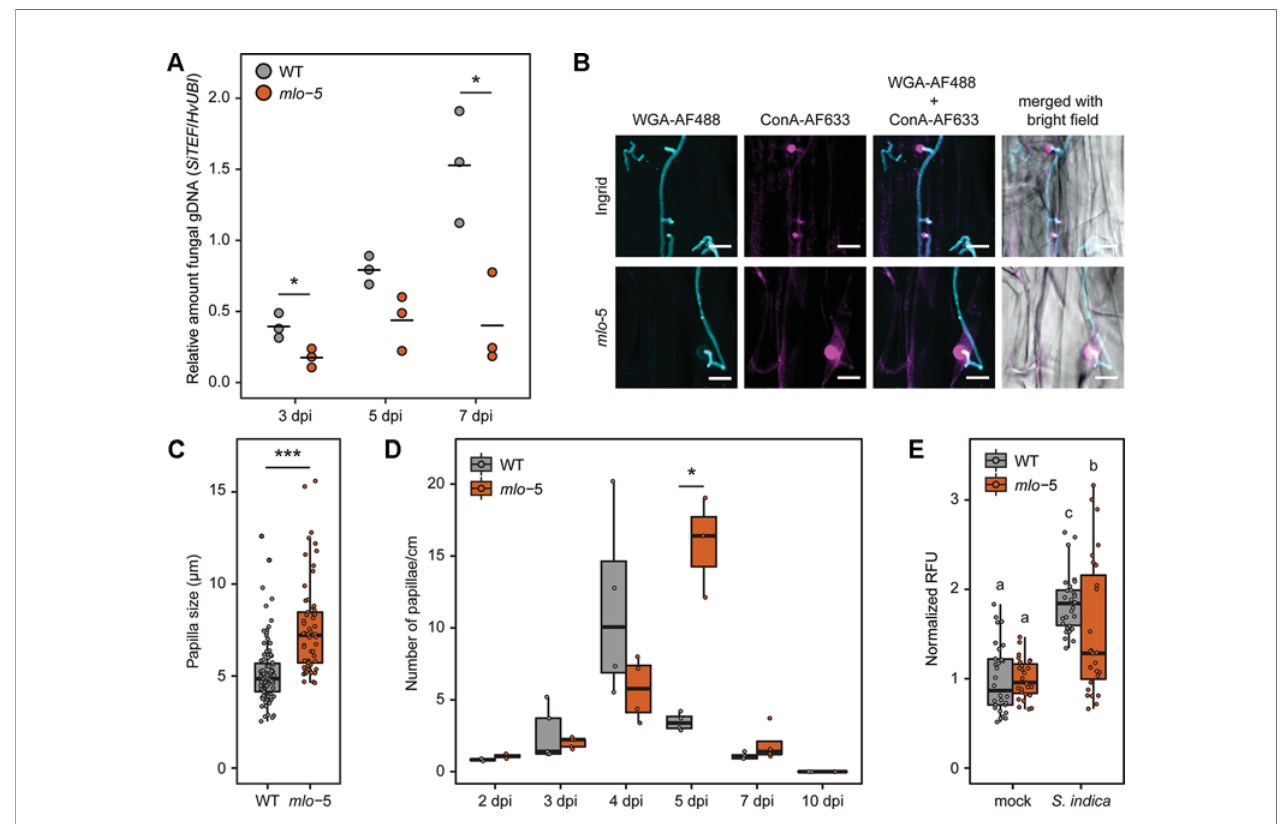
FIGURE 1 | Reduced S. indica colonization of barley mlo -5 coincides with enhanced root defense. Three-day-old barley seedlings were inoculated with a S. indica chlamydospore suspension at a fi nal concentration of 5x10 5 spores/ml in Tween20-water or Tween20-water alone as mock treatment. (A) At 3, 5, and 7 days post inoculation (dpi) seedlings were removed from jars and gDNA was extracted from inoculated root sections as described in the Materials and Methods . Fungal colonization in each biological replicate was con fi rmed by quantitative PCR ( n = 3). Statistically signi fi cant differences in the relative abundance of fungal gDNA during colonization of wild type (WT) and mutant mlo- 5 plants were determined with Welch two sample t tests (* p < 0.5). (B) Roots of inoculated WT and mlo -5 plants were collected and stained with 10 m g/ml Wheat Germ Agglutinin (WGA-AF488, cyan) and 10 m g/ml concanavalin A (ConA-AF633, magenta) for visualization of fungal structures and papillae, respectively. Confocal microscopy shows extraradical growth of S. indica and hyphal penetration attempts of WT and mlo- 5 root tissue. At these sites, the barley host responds with papillae formation. (C) Sizes of papillae formed in colonized WT ( n =95) and mlo- 5 ( n = 61) roots were determined based on confocal microscopy pictures taken at 3, 4, 5 and 7 dpi. The statistically signi fi cant difference in papilla size between wild type (WT) and mutant mlo- 5 plants throughout colonization was determined with the Welch two sample t test (*** p < 0.001). (D) The number of papillae formed in colonized WT and mlo- 5 roots was quanti fi ed based on confocal microscopy pictures taken at 2, 3, 4, 5, 7, and 10 dpi ( n = 2-4). Statistically signi fi cant differences in papilla quantity between barley genotypes were determined with Welch two sample t tests (* p < 0.5). (E) Mock-treated and S. indica -colonized roots of WT and mutant plants were harvested at